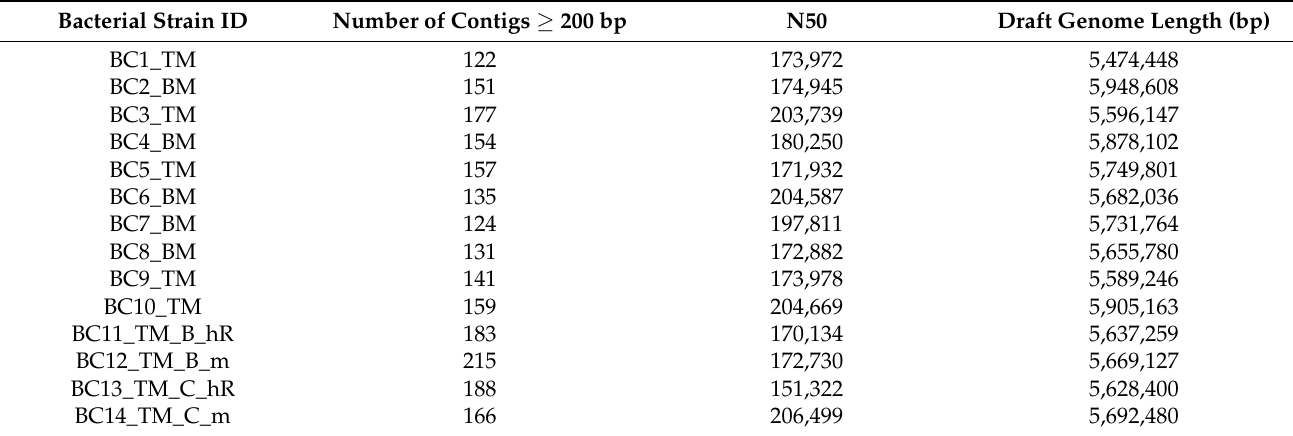
Table 3. Quality control parameters for draft